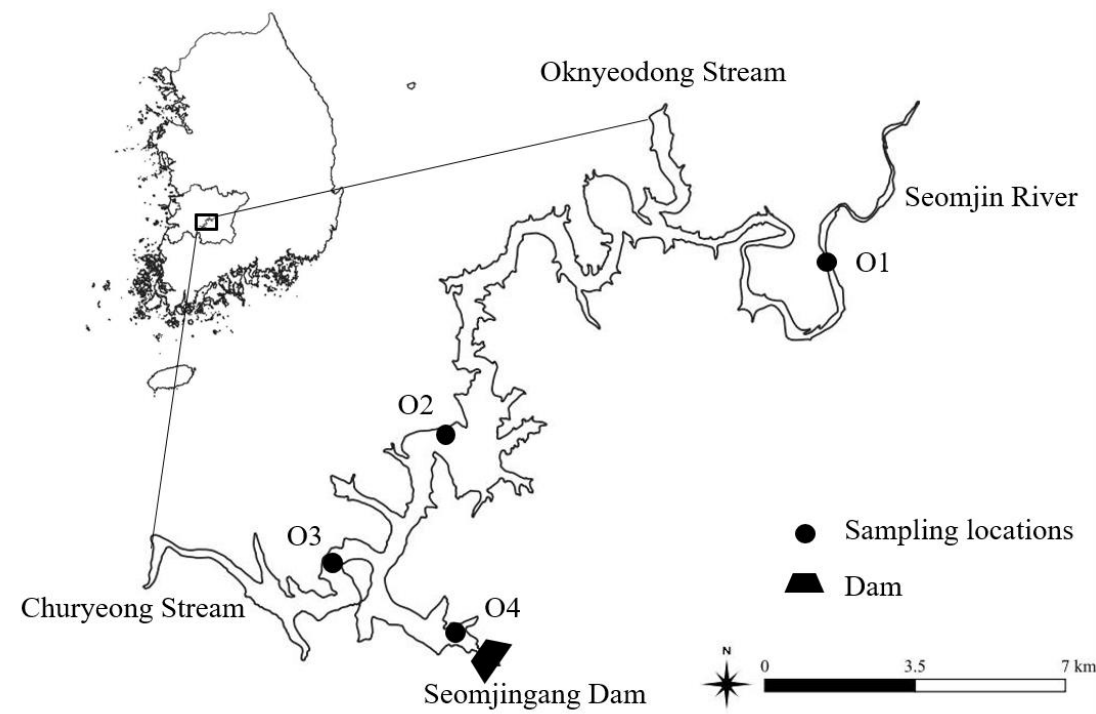
Figure 1. The map of the study area with sampling locations in the Okjeong Reservoir.